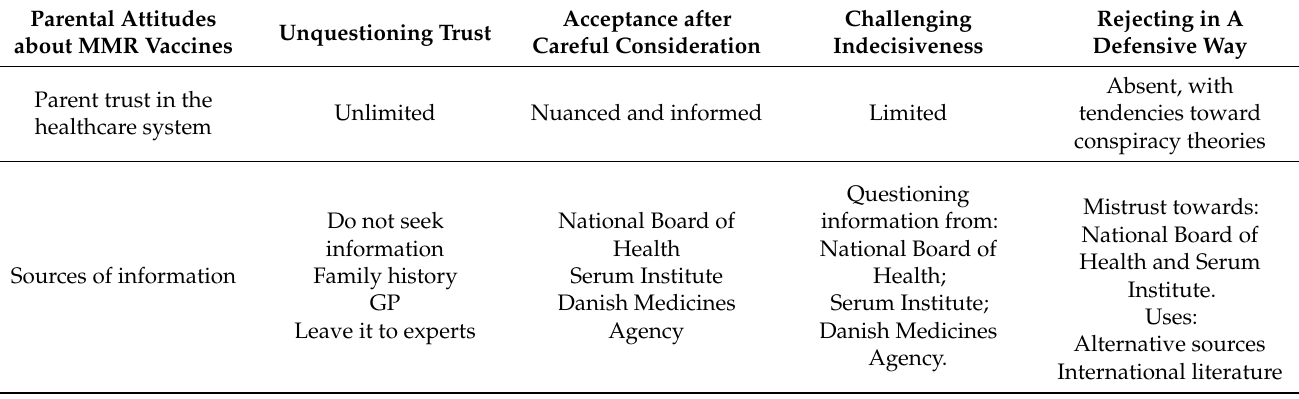
Table 3. Parental attitudes about MMR and advanced MMR1 administration and HCPs’